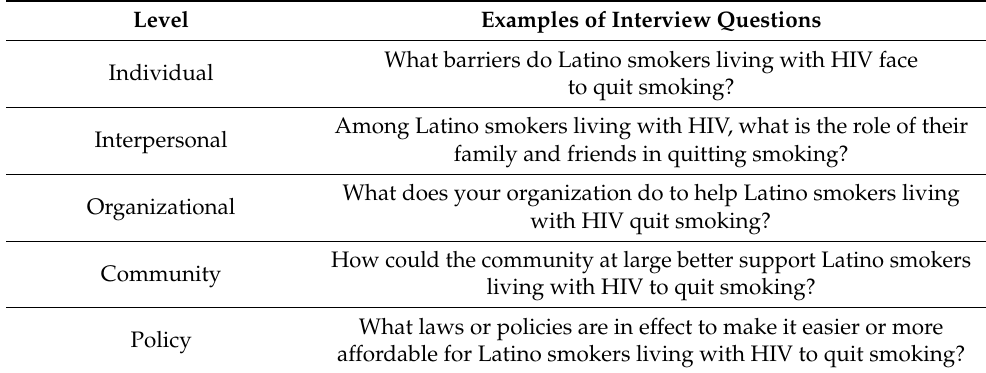
Table 1. Examples of the interview questions using the social ecological